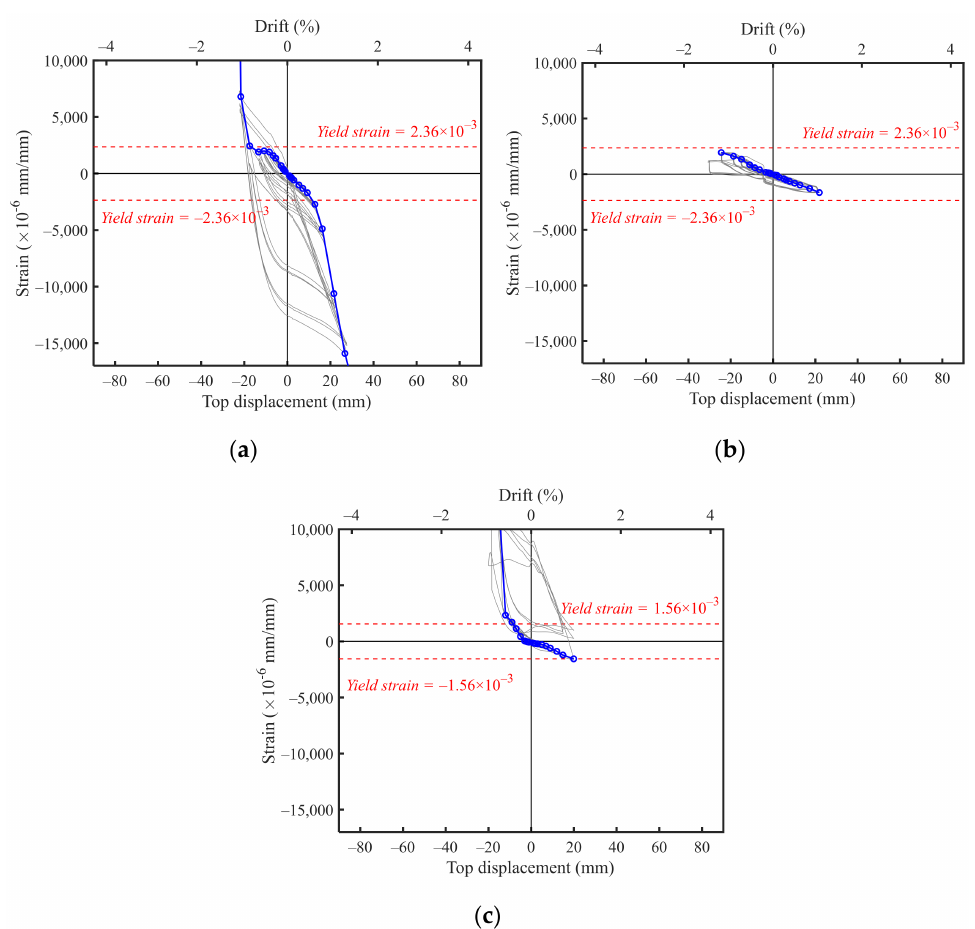
Figure 18. Strain response of vertical bars (No. 1 gauge in Figure 10). ( a ) W0; ( b ) W1-R; ( c )